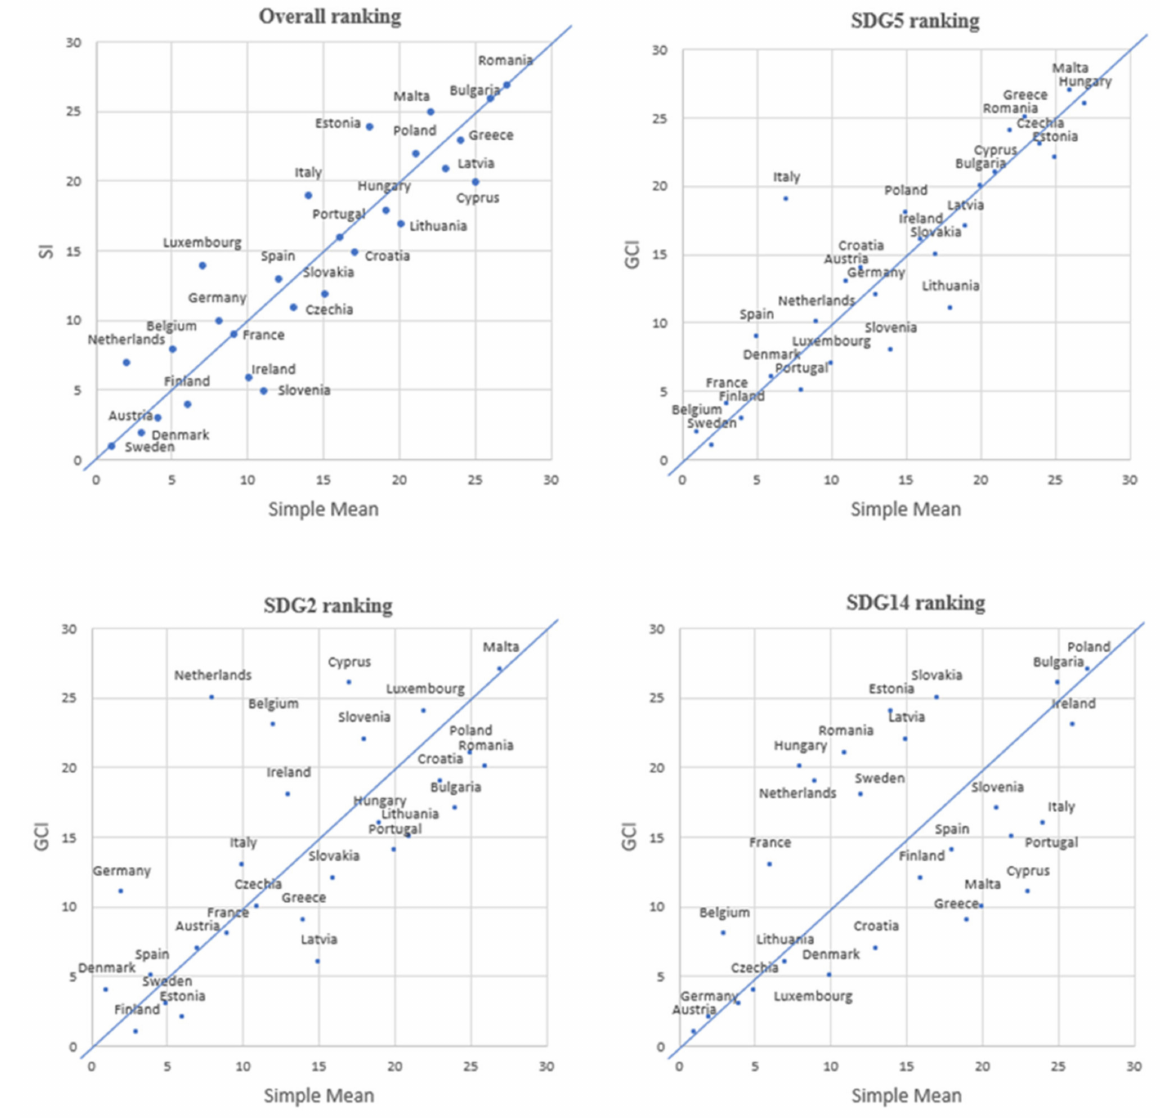
Figure 2. Comparison of rankings with proposed approach and simple mean